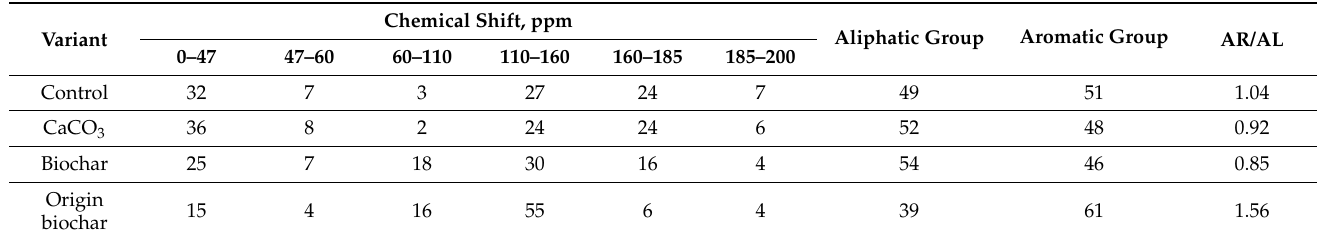
Table 5. Contents of molecular fragments of HAs formed during decomposition of clover leaves, 90 days of composting (from 13 C-NMR